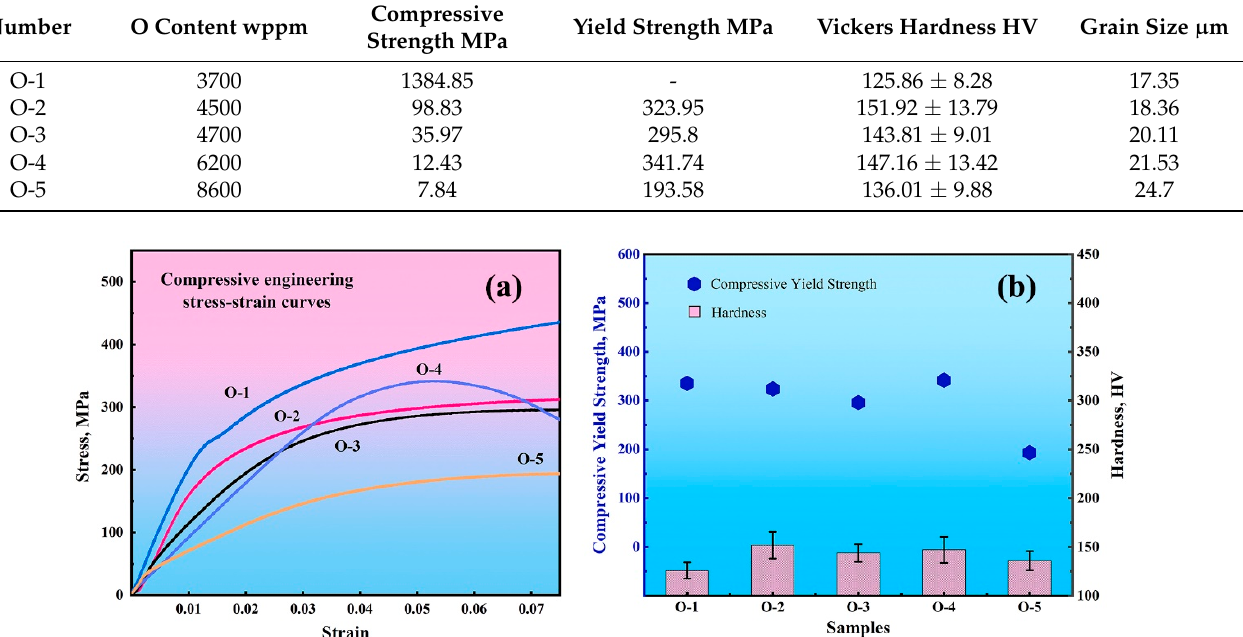
Figure 11. ( a ) Compressive engineering stress–strain curves of O-1 to O-5 samples deformed at 0.001 s − 1 strain rate. ( b ) The Vickers hardness of O-1-to-O-5-sintered samples in the same region.